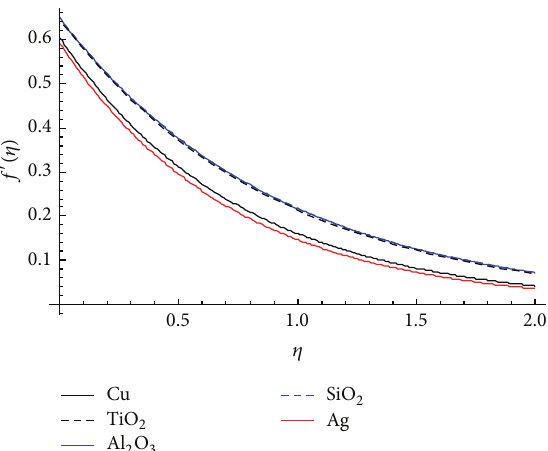
Figure 1: Effect of the volume friction 𝜙 of Cu-water nanoparticles on velocity distribution 𝑓 󸀠 (𝜂) at different values of 𝑠 when 𝑃𝑟 = 6.2 , = 1 , and 𝛿 = 0 . 𝛿 1 2